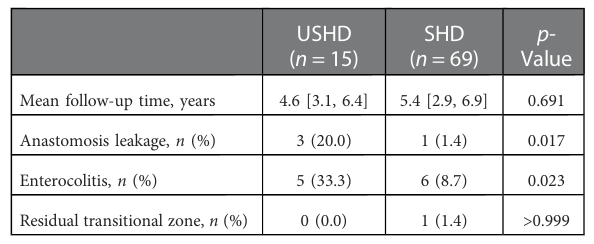
TABLE 3 Postoperative complications.